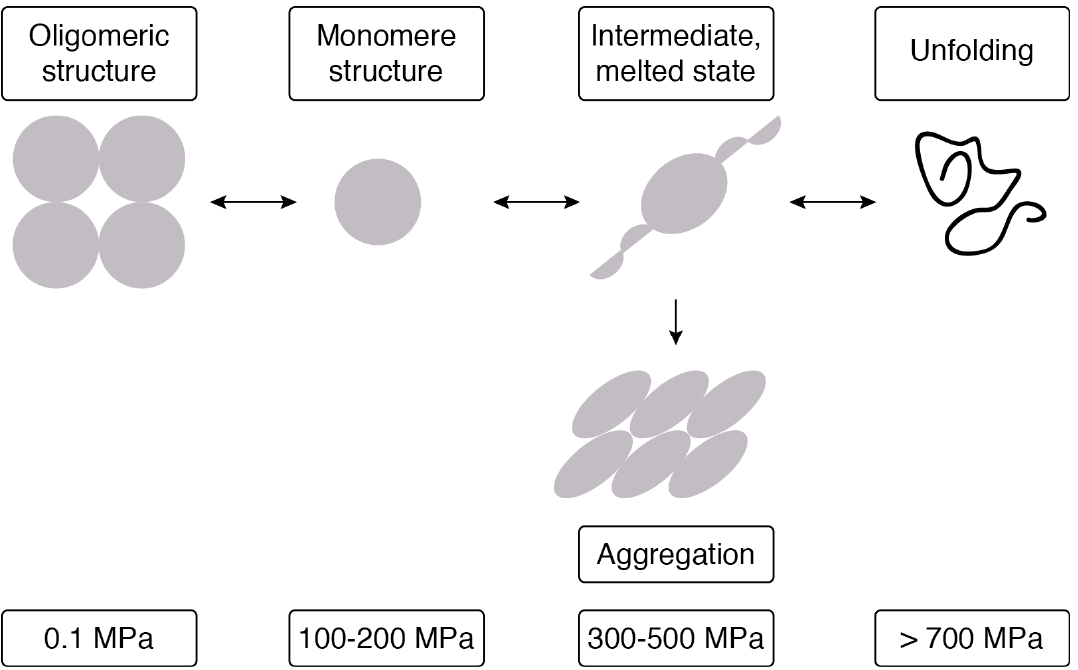
Figure 3. Scheme of protein structure modification by high-pressure processing. Adapted from Bolumar et al. [68].